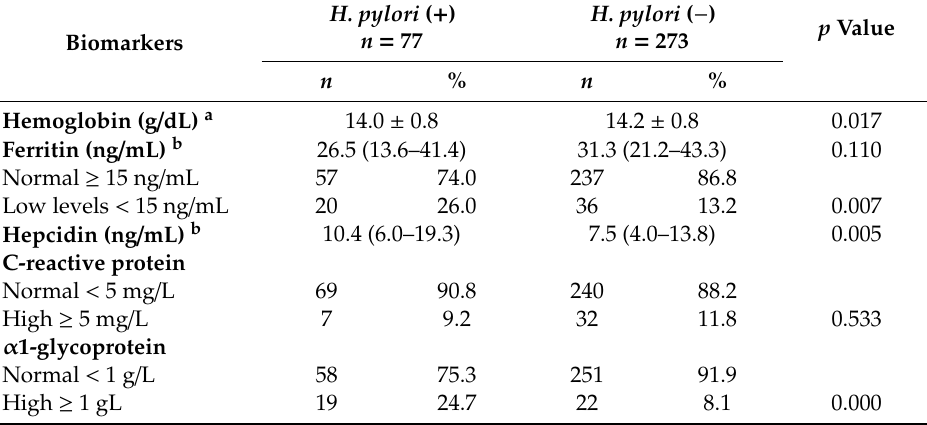
Table 3. Iron status, hepcidin, and inflammation markers by H. pylori infection.